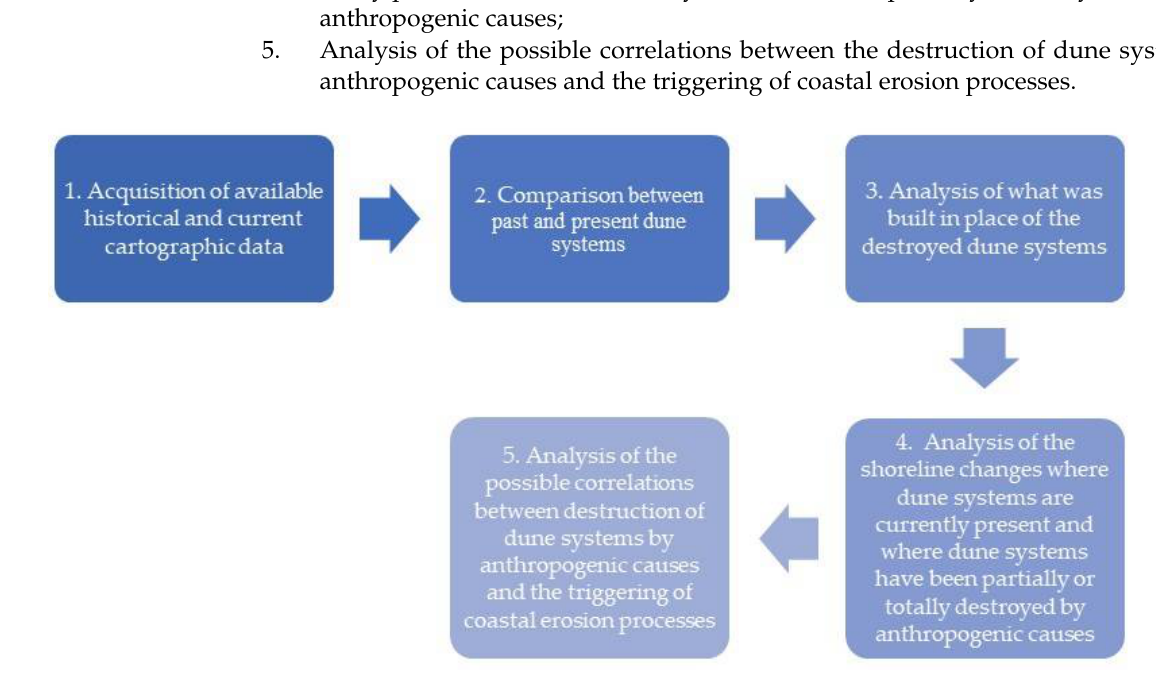
Figure 2. Flow chart of the proposed methodology.